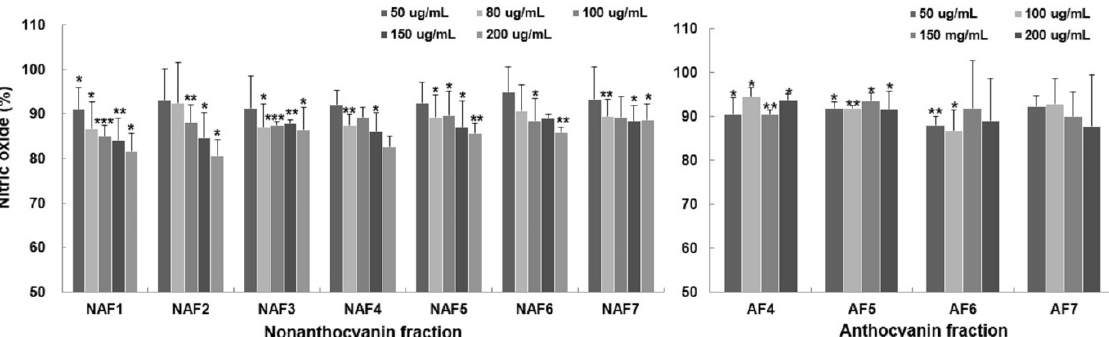
Fig. 1: Nitric oxide production of Raw264.7 cells treated with nonanthocyanin fraction (NAF, maturity stage 1-7) and anthocyanin fraction (AF, maturity stage 4-7). Untreated control cells were set at 100. Bars represent means ± standard deviations (n=3). Statistical significance is based on the difference when compared with the cells without treating extracts (* P <0.05, ** P <0.01, and *** P